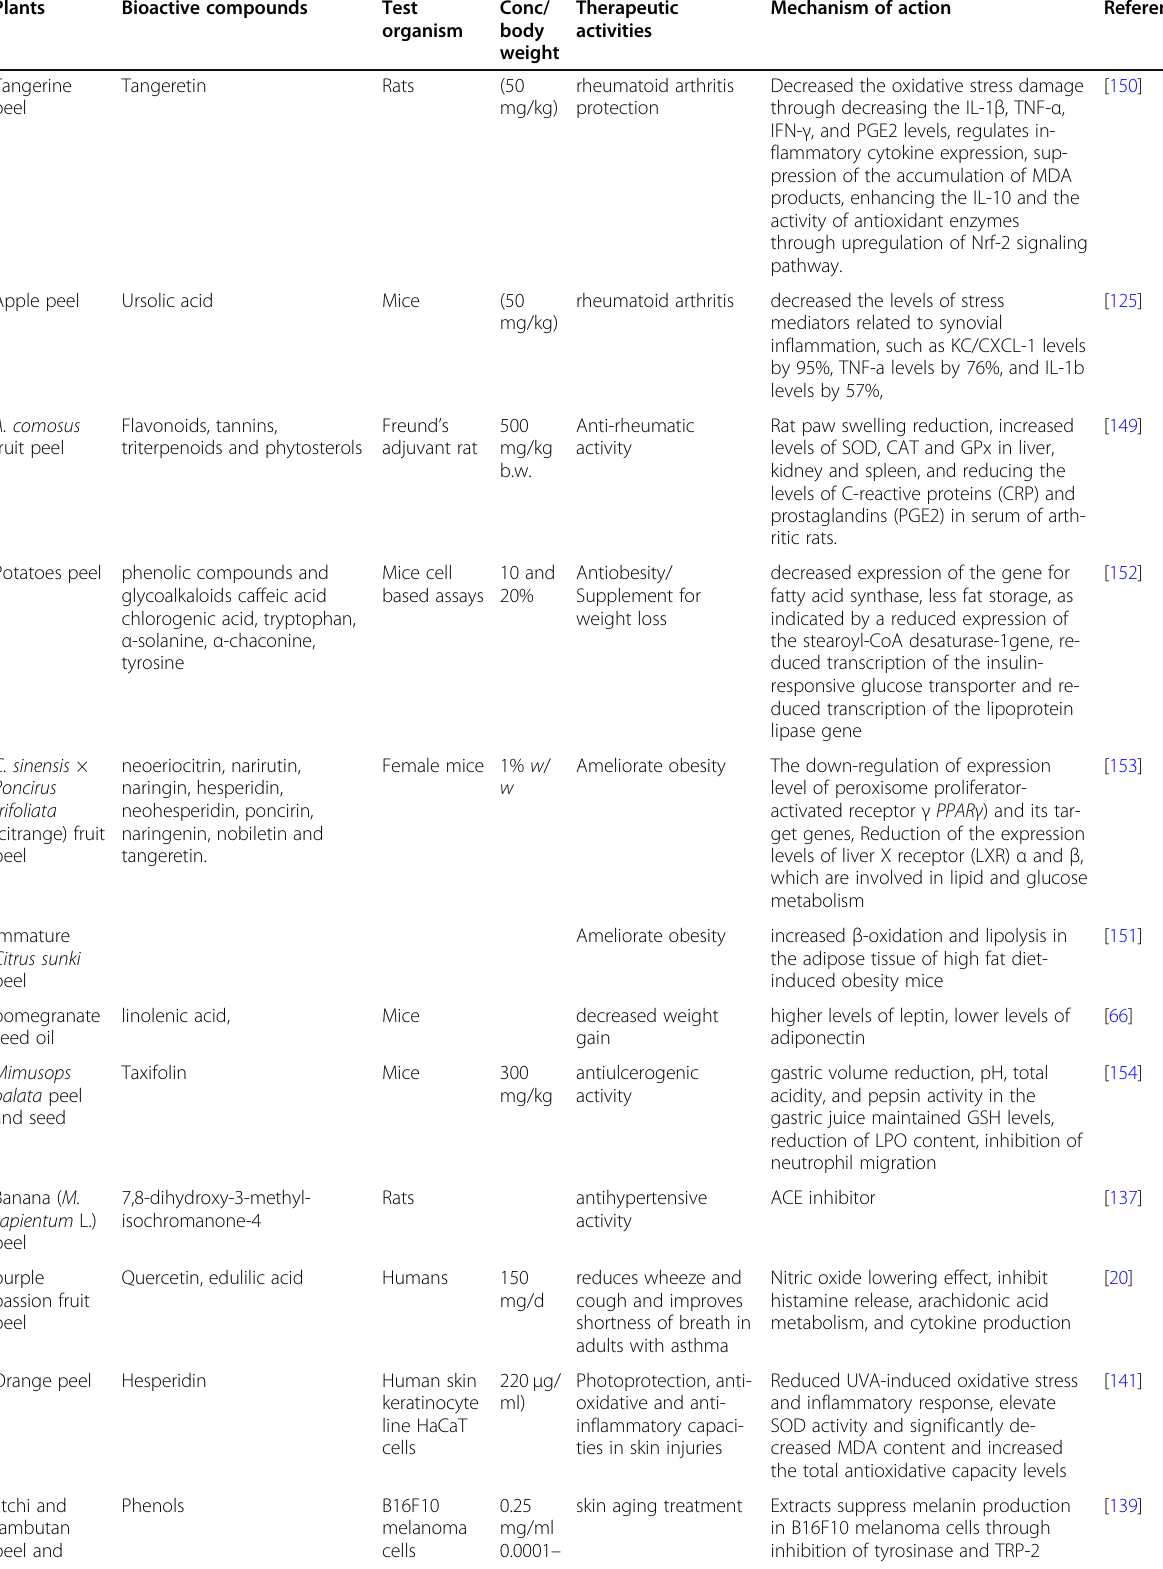
Table 9 other therapeutic properties of some peels and seed extracts